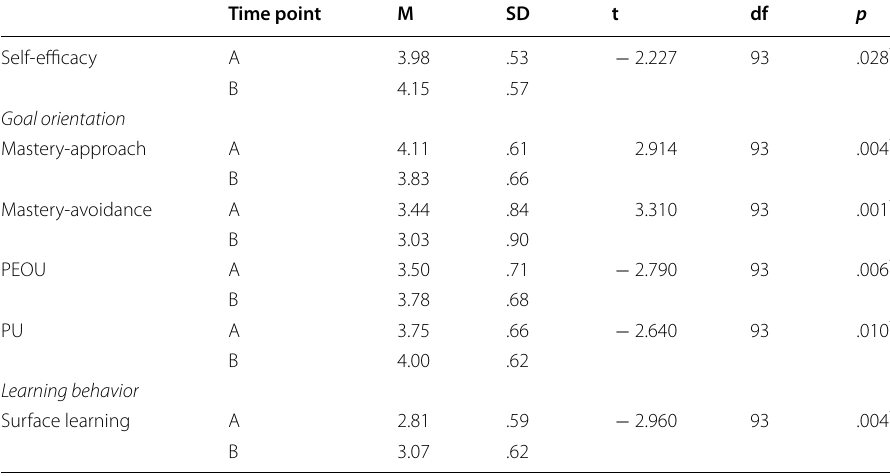
*Significant at a confidence level of p < 0.025 (2‑tailed) **Significant at a confidence level of p < 0.05 (2‑tailed)